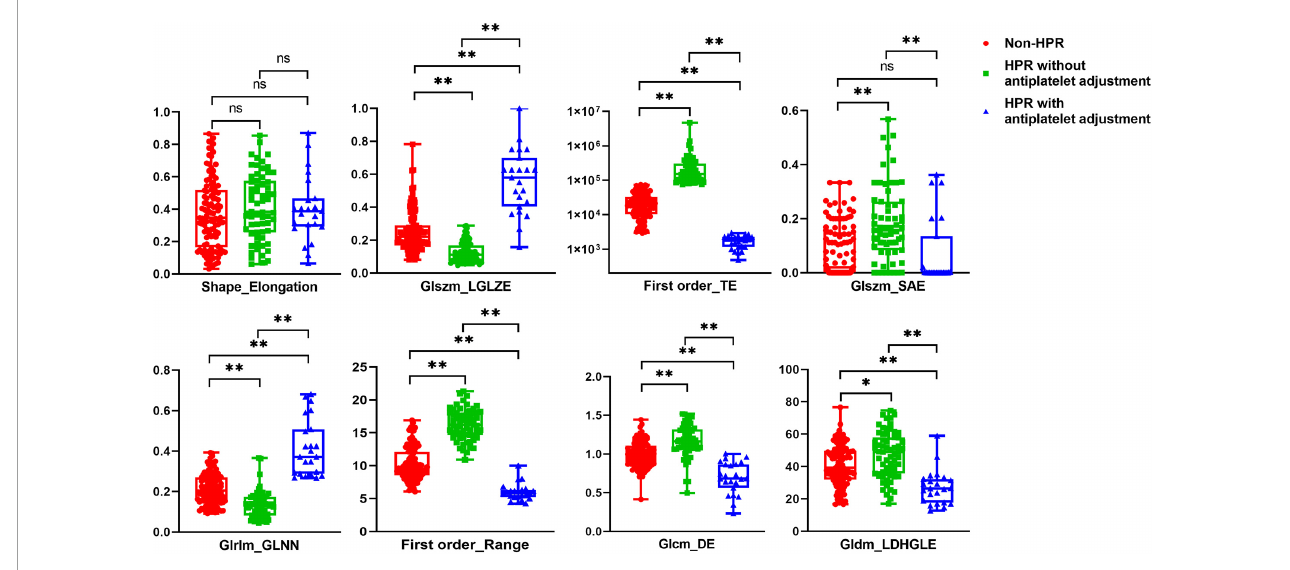
FIGURE3 Comparison of the eight selected radiomics features in patients with non-high on-treatment platelet reactivity (HPR), HPR without antiplatelet adjustment, and HPR with antiplatelet adjustment. * p < 0.05, ** p <